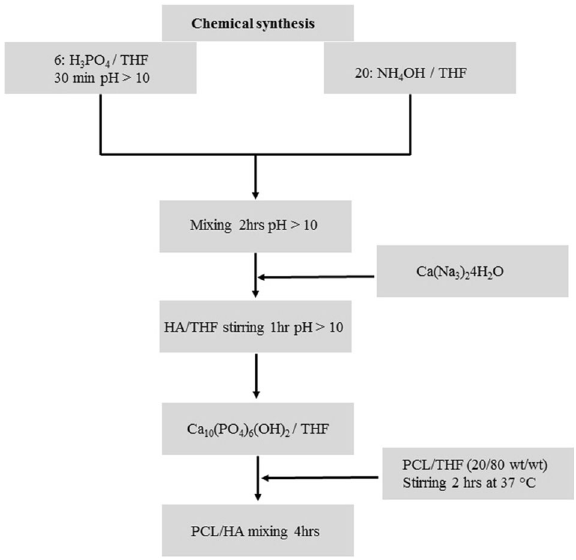
Fig. 2 Flow chart of PCL/HA scaffold preparation by chemical